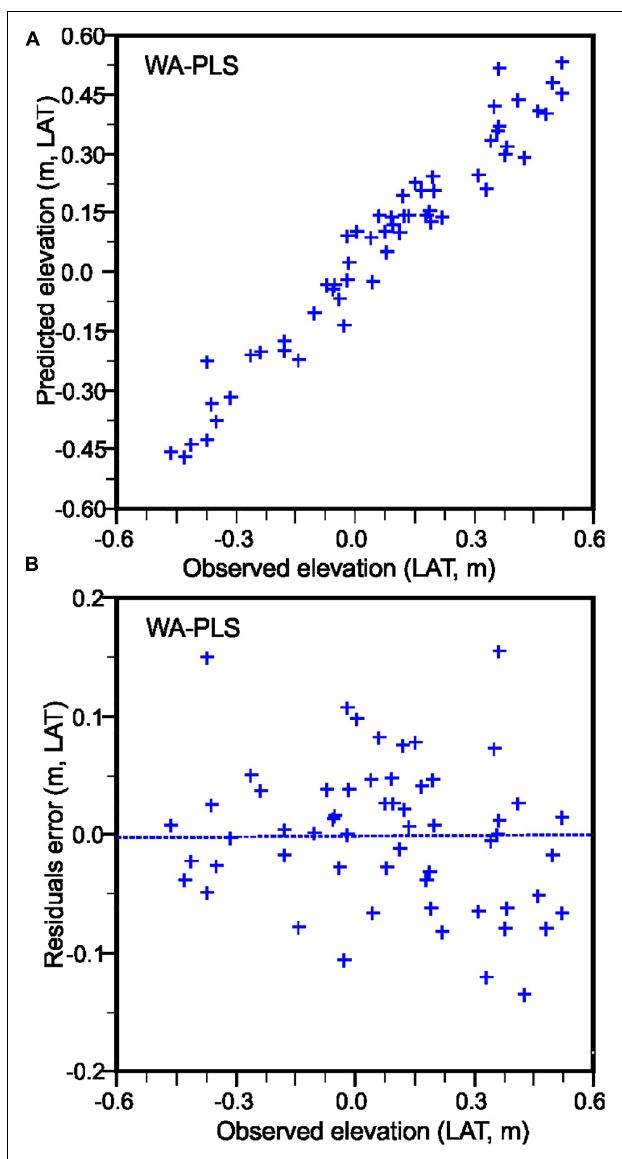
FIGURE 8 | (A) Samples elevations predicted by the WA-PLS regression model, compared with observed elevations. (B) Residual errors of WA-PLS is calculated by (subtracting the observed elevations from the inferred elevations) and using the modern training set data (75 samples and 99 species).